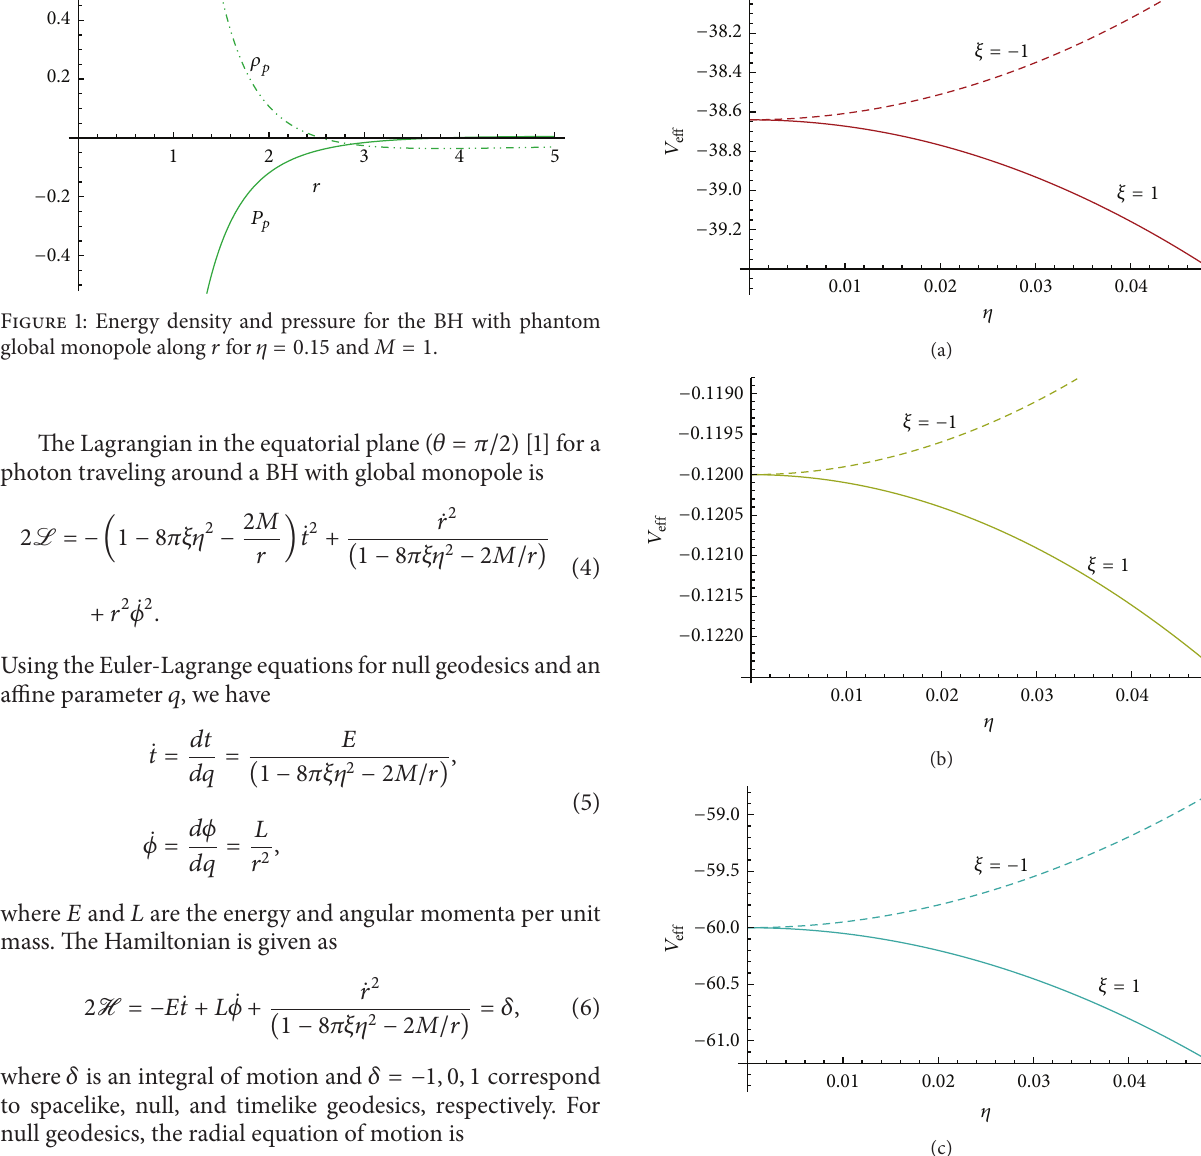
Figure 2: Behavior of the effective potential ( 𝑉 phantom global monopoles as function of 𝜂 corresponding to 𝐿 =